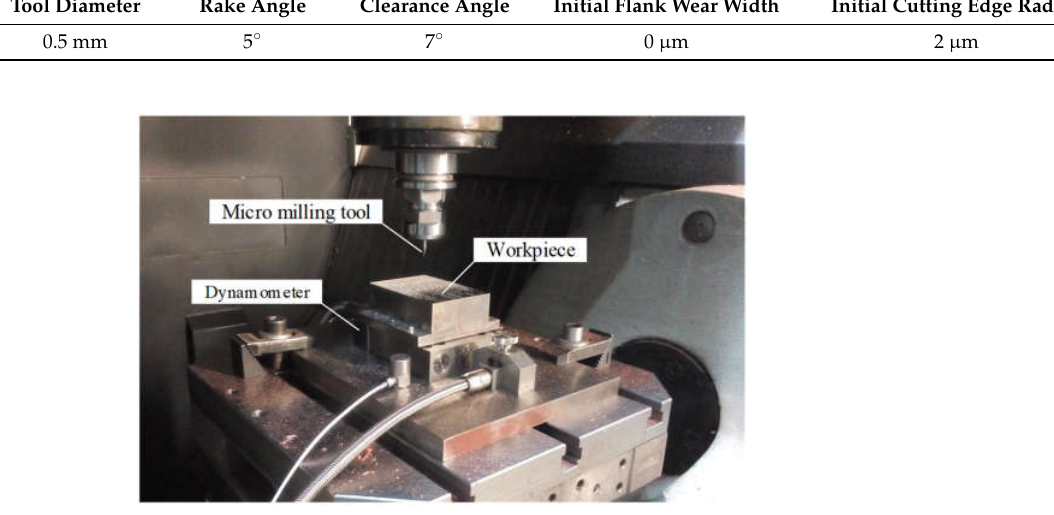
Figure 4. Experimental setup.